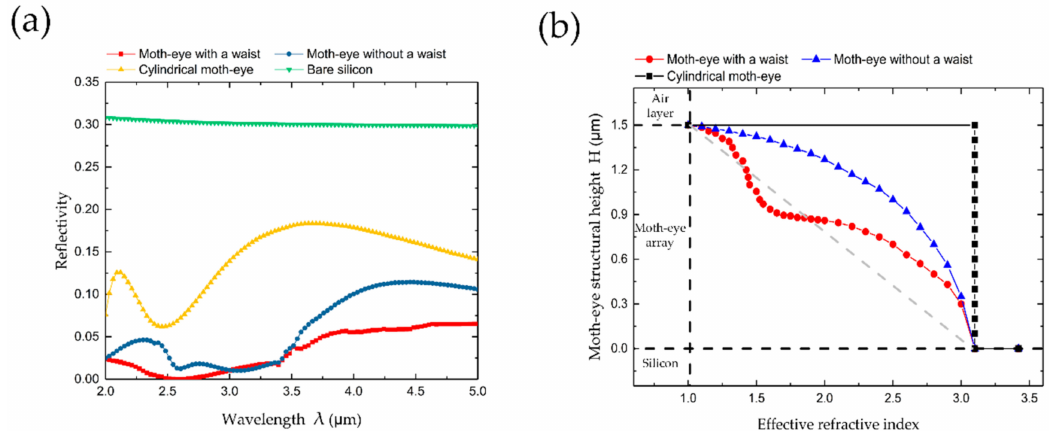
Figure 2. Reflectivity and effective refractive index of moth-eye structures with different morphologies (normal incidence): ( a ) comparison of the reflectivity of moth-eye structures with different morphologies; ( b ) comparison of the effective refractive index of moth-eye structures with different